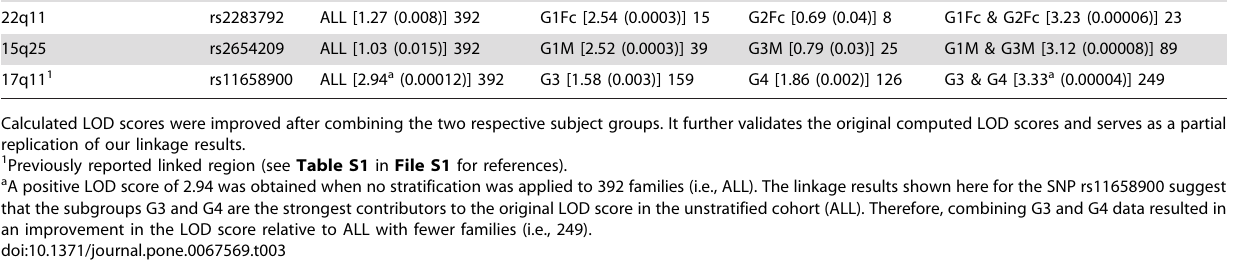
Overlapped region